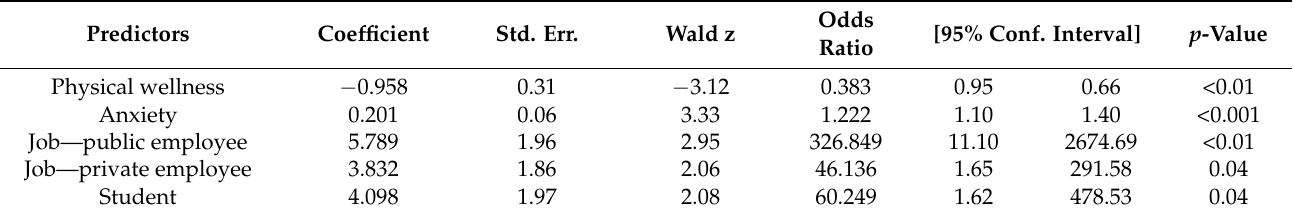
Table 2. Backward Logistic regression: significant predictors of sleep disorder in COVID-19 quarantine.